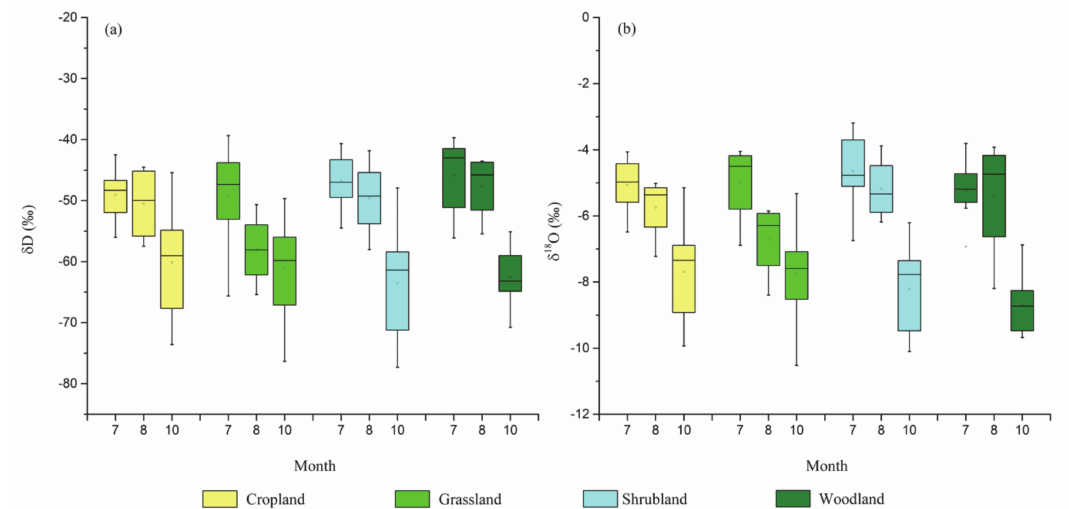
Figure 2. Temporal variations in δ D and δ 18 O in soil water under four land uses over the current study (( a ) δ D, ( b ) δ 18 O).